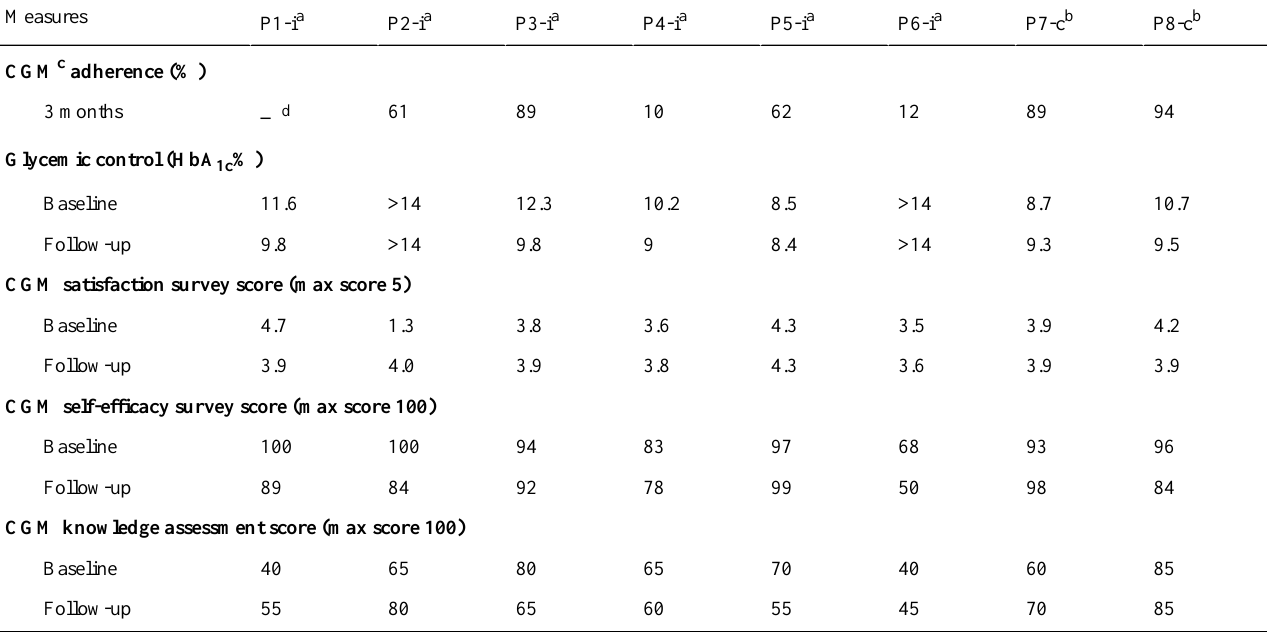
Table 4. Diabetes-related outcome measures at baseline and follow-up per